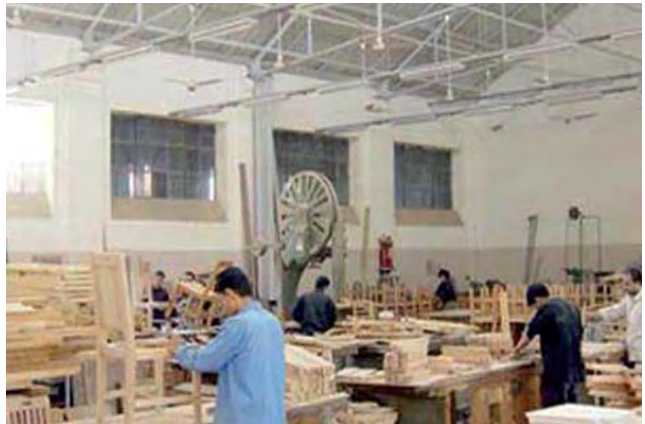
Figure 8. Image of Workshops in Furniture city